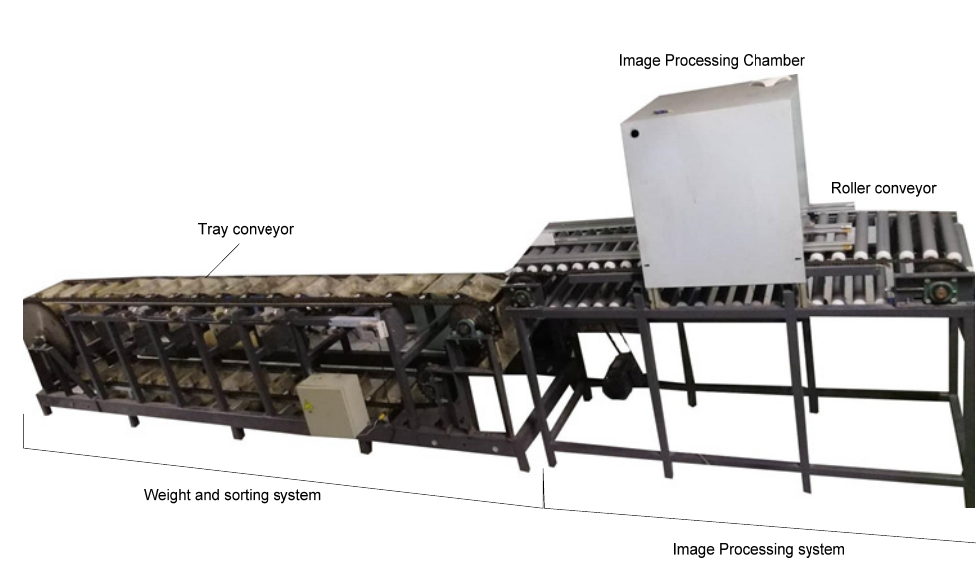
Figure 1. Mango grading and sorting system used in the study.